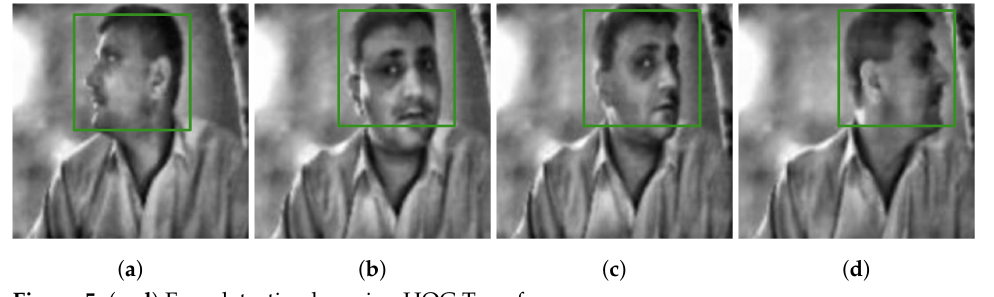
Figure 5. ( a – d ) Face detection by using HOG